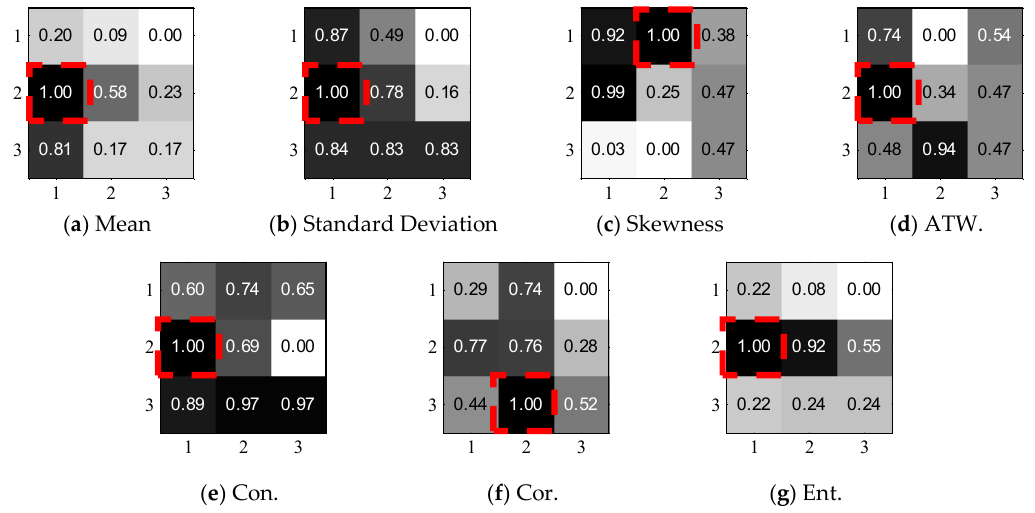
Figure 6. Experiment Study by Comparing Color and Texture Features in Different Regions.